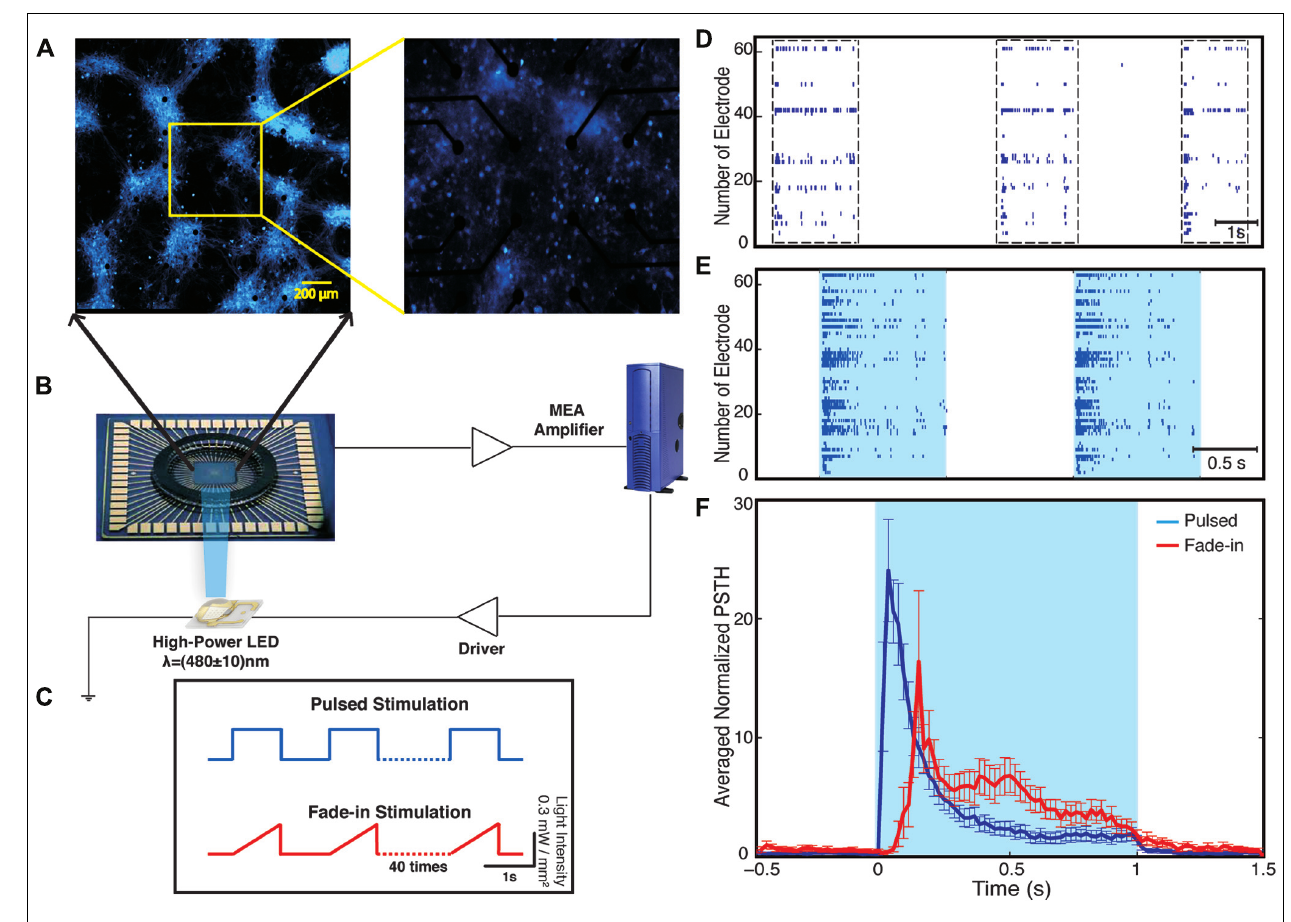
FIGURE 2 | Optical network electrophysiology. Panel (A) shows the experimental setup including channelrhodopsin-2 transduced neurons cultured on a multi-electrode array stimulated by whole-field blue light illumination using a high-power LED (B) . The data is acquired by a MEA amplifier and a recording computer. The cultures are stimulated with either pulsed or fade-in stimuli (C) . Panel (D) shows a representative raster plot of